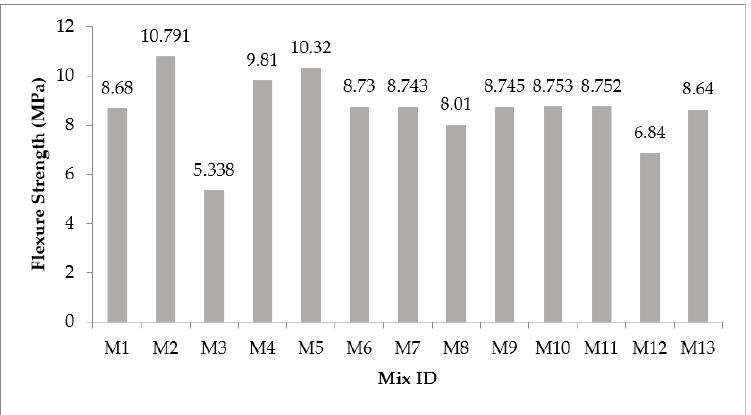
Figure 6. Flexural strength of SCC at 28 days. Determined from ANOVA using RSM, the model for estimating the 28-day FS of the SCC using two variables which are fly ash and GO is presented as Equation (3). The effect of fly ash and GO on the FS of the SCC is plotted in form of 3-dimensional response surface plot as shown in Figure 7.